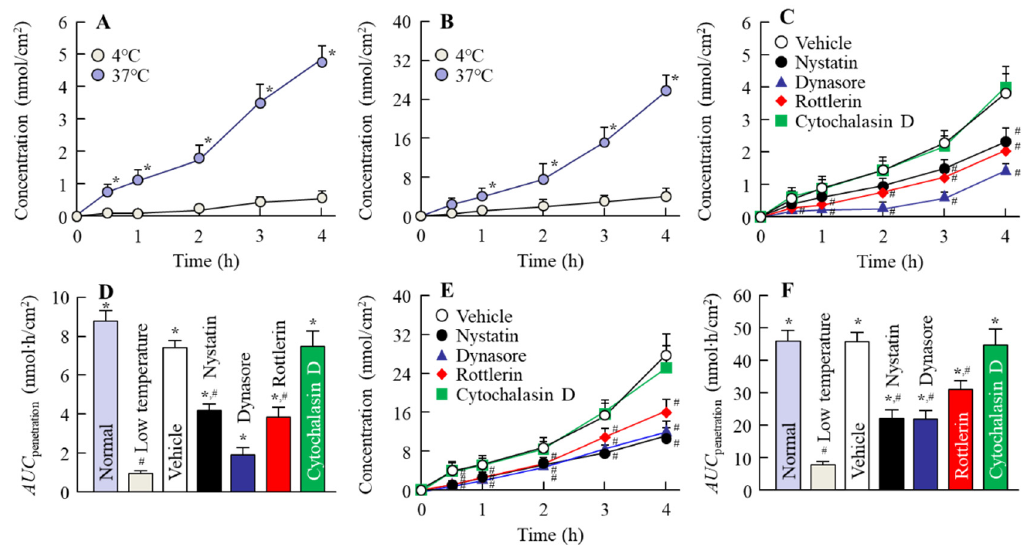
8 of 15 Figure 3. Trans-epithelial penetration of MLX from MLX-NPs (0.2 mg/mL) through Caco-2 cell monolayers. ( A ) Penetration of MLX formulations through Caco-2 cell monolayers. ( B ) AFM image of MLX-NPs on the basolateral side. ( C ) Number of nanoparticles from MLX-NPs on the basolateral side. ( D ) Accumulation of MLX in Caco-2 cells treated with MLX formulations. ( E ) TER of Caco-2 cell monolayers after treatment with MLX formulations. N.D., not-detected. n = 8. * P <0.05 vs. MLX-TDs